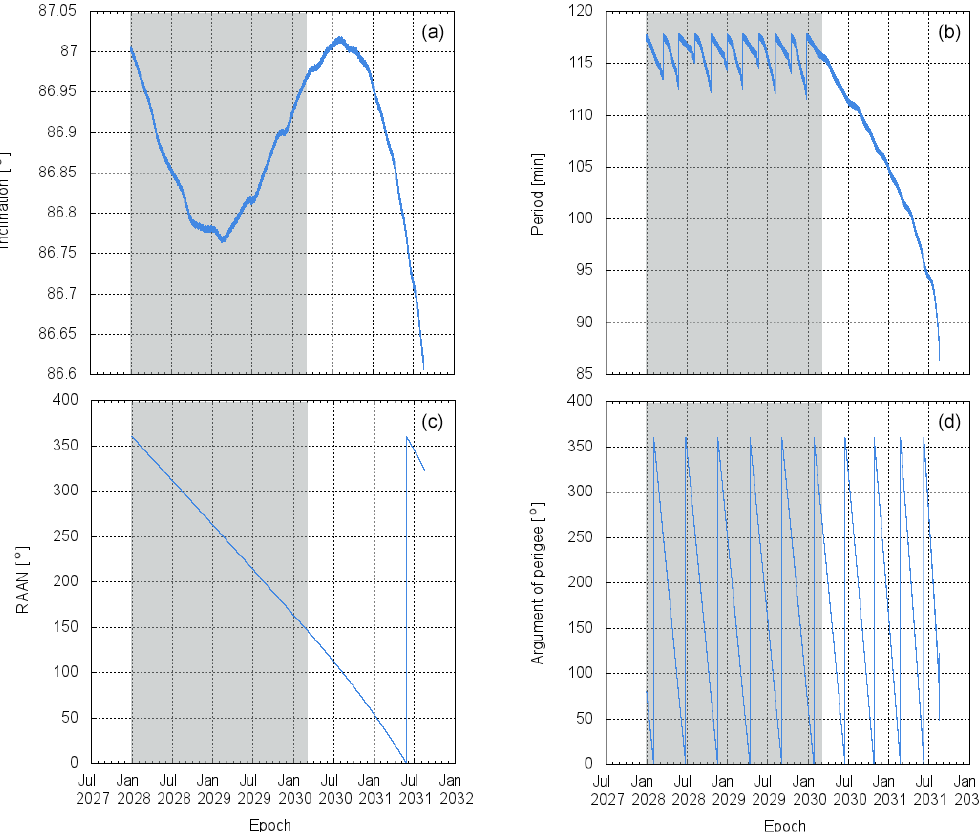
Figure 17. Long-term evolution of the Daedalus inclination (a) , period (b) , right ascension of the ascending node (RAAN) (c) and argument of perigee (d)